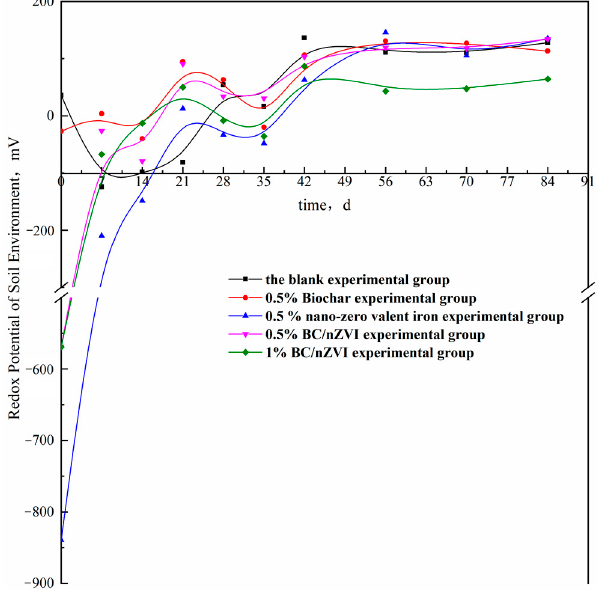
Figure 6. Effect of material addition on the redox potential of the soil environment.